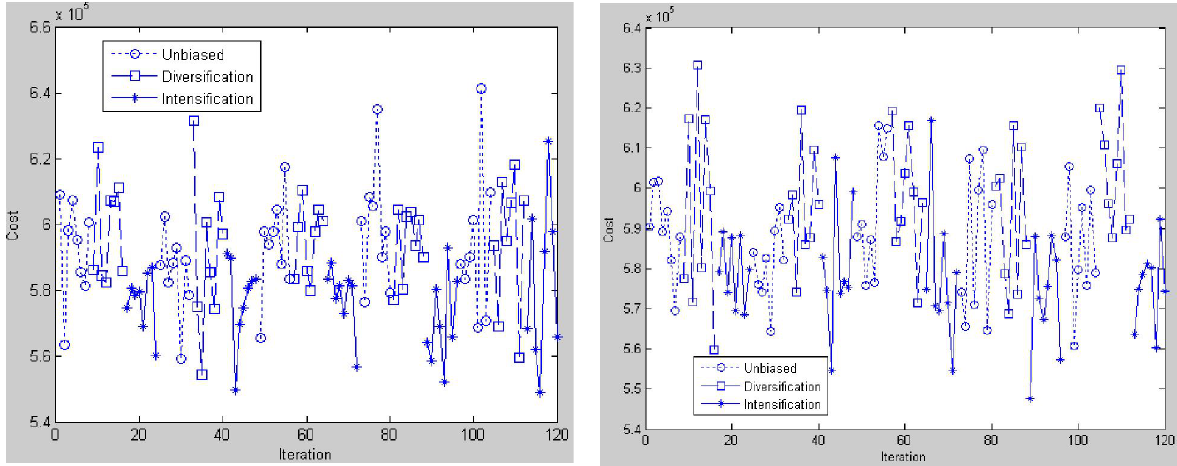
Fig. 10. Result of Run 1 Fig. 11. Result of Run